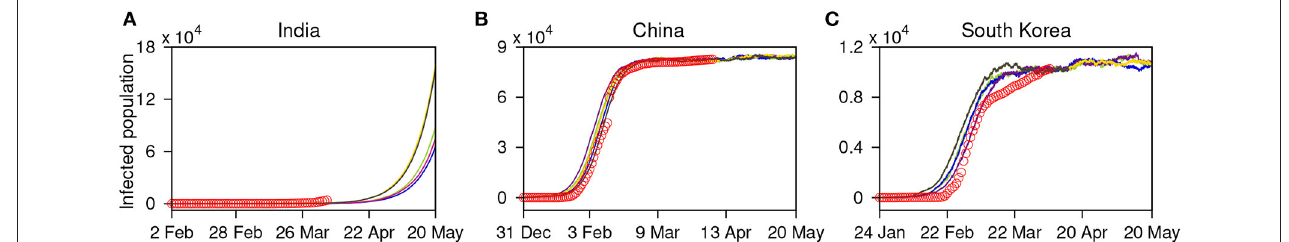
FIGURE 8 | Stochastic trajectories (marked with pink, yellow, gray, green, and blue curves) of the infected population generated using the Gillespie algorithm for: (A) India, (B) China, and (C) South Korea. The original datasets up to April 6 for the respective countries are depicted by circular (red) points for a